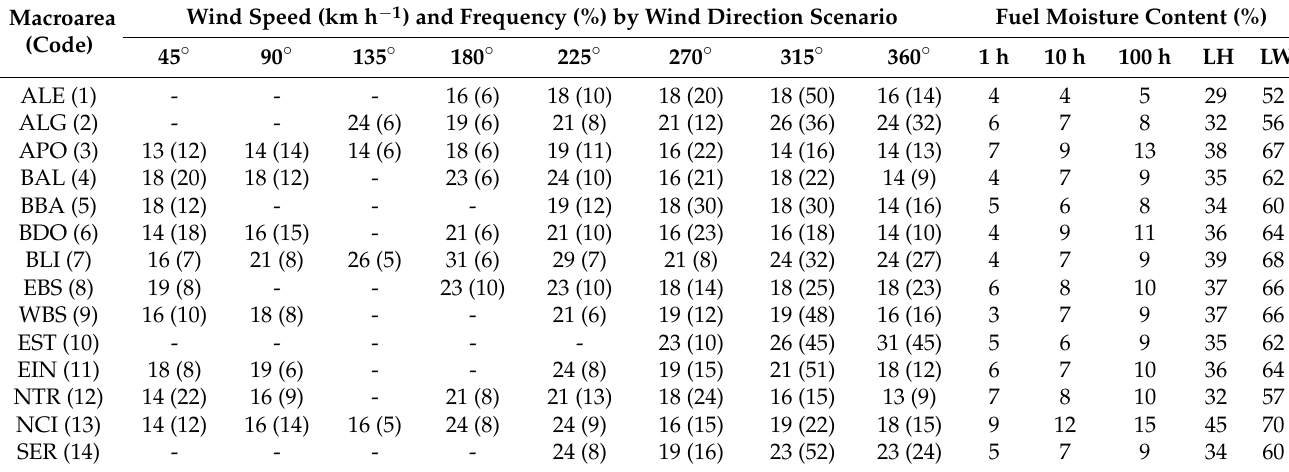
Table 1. Extreme fire weather conditions (99th percentile) for Portugal’s different macro-areas or pyro regions (Figure 1A). We determined the wildfire season winds (speed and direction), frequency scenarios, and fuel moisture content for each macro-area. Abbreviations: Alentejo (ALE), Algarve (ALG), Alto Portugal (APO), Beira Alta (BAL), Beira Baixa (BBA), Beira Douro (BDU), Beira Littorals (BLI), Eastern Beira Serra (EBS), Western Beira Serra (WBS), Estremadura (EST), Estremadura interior (EIN), Northeast Transmontane (NTR), Northeast Cismontane (NCI), and Sado e Ribajejo (SER).